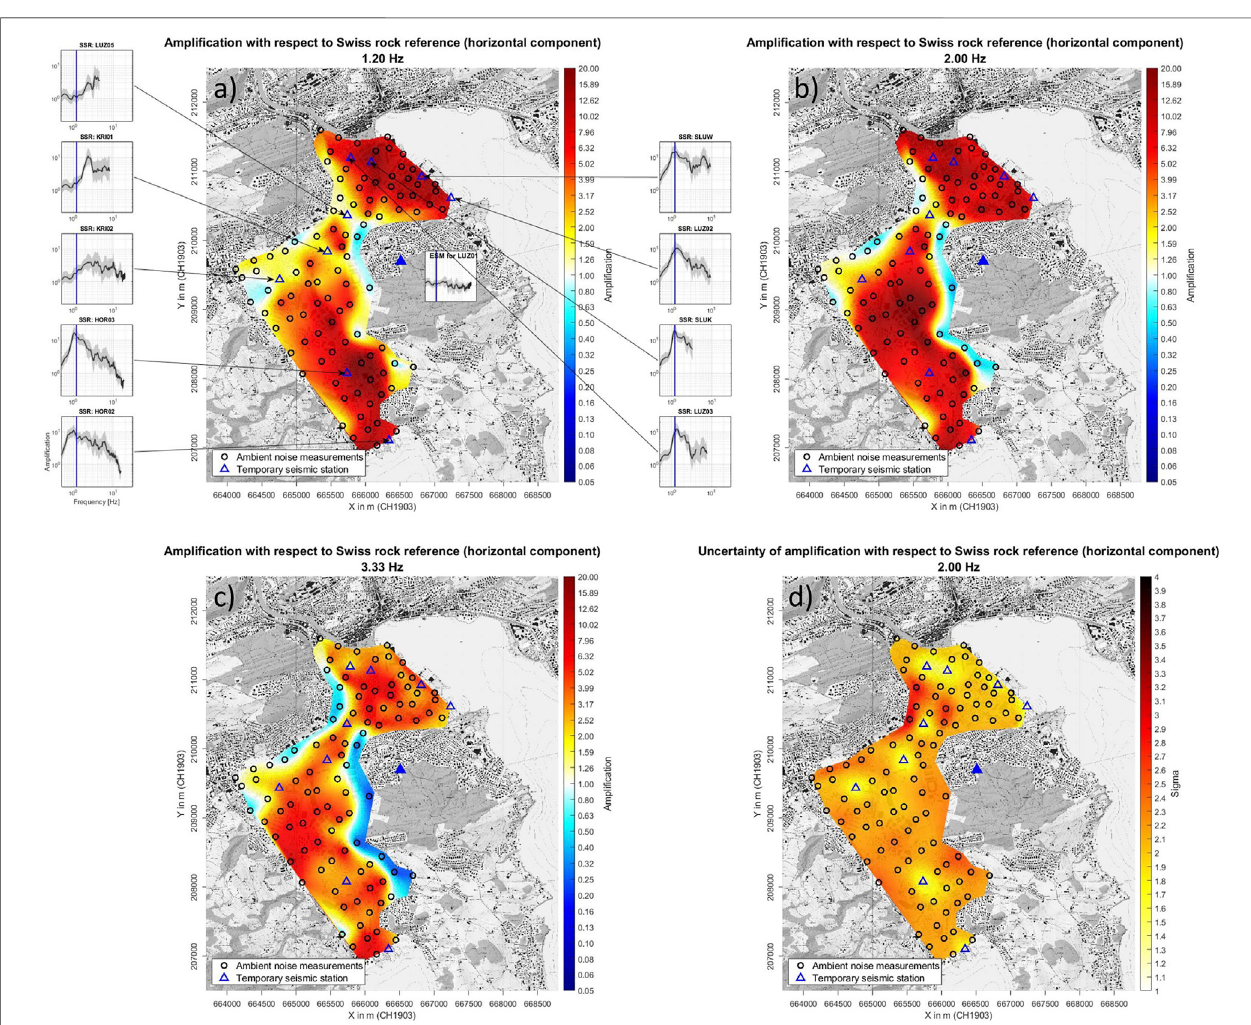
FIGURE8| Ampli fi cationfactorswithrespecttotheSwissreferencerockpro fi lefortheLucerneareafor (A) 1.2Hz, (B) 2 Hz,and (C) 3.33 Hz.Bluetrianglesarethe stations of the seismic monitoring network, and black circles represent ambient vibration measurements. The ampli fi cation functions referenced to the Swiss reference rock pro fi le for the stations are shown outside the map (A) ; blue lines show the value for 1.2 Hz. (D) Standard deviation for the ampli fi cation map for 2 Hz.